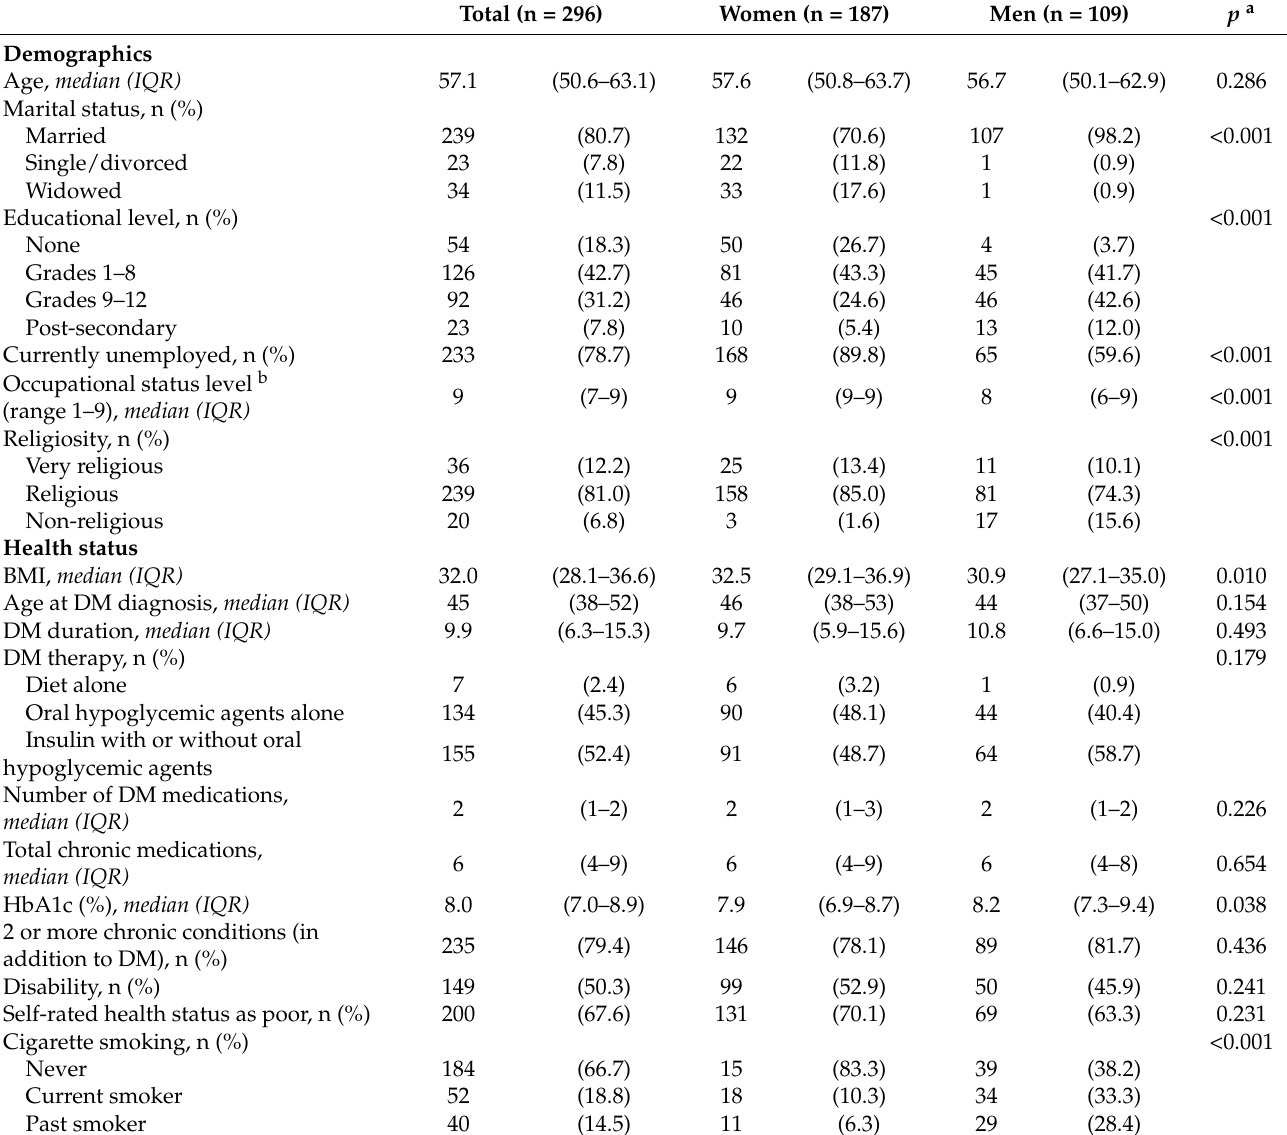
Table 1. The selected characteristics and diabetes-related behaviors of DAPI interview respondents by gender (n =